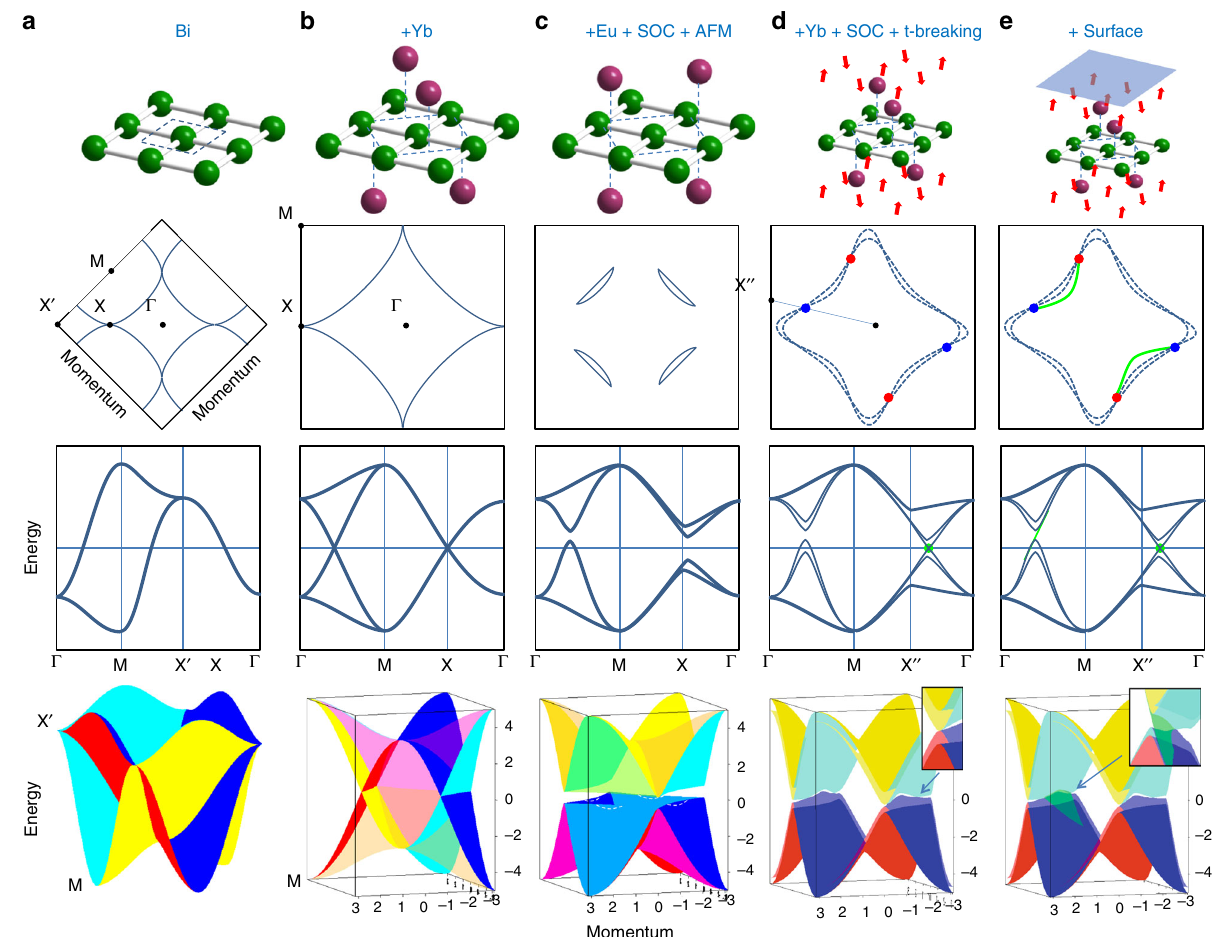
Fig. 5 Emergence of the time-reversal type-II Weyl state. Schematic electronic structures corresponding to the structural fragment shown in the upper panel (from top to bottom): Fermi contour, band structure along selected directions, 3D E( k ) representation in the whole BZ. a 2D network of Bi atoms. b Bi-network surrounded by Yb atoms in staggered geometry. c Bi-network surrounded by Eu atoms in coincident geometry. Spin – orbit coupling and perfect antiferromagnetism are taken into account in the calculations. White dashed lines in the lowest panel indicate where the sheets cross the Fermi level. d Case with Yb and canted AFM which results in lifted degeneracy and creation of Weyl points. Inset to the lowest panel shows the cut through one of the Weyl points. e Presence of the surface induces the non-trivial surface states (green planes) connecting the Weyl points (green